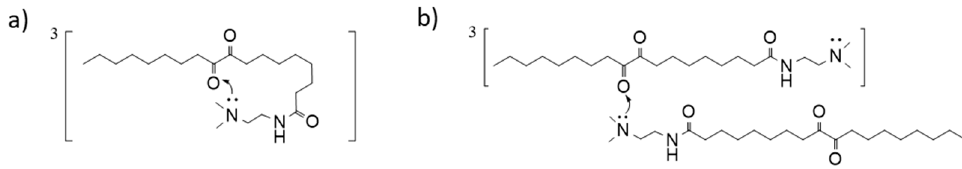
Figure 1. Structures of the alkyl amide derivatives of 9,10-dioxooctadecanoic acid (DODA) exam- ined: N-isobutyl-9,10-dioxooctadecanamide (DIBA), isopentyl-9,10-dioxooctadecanamide